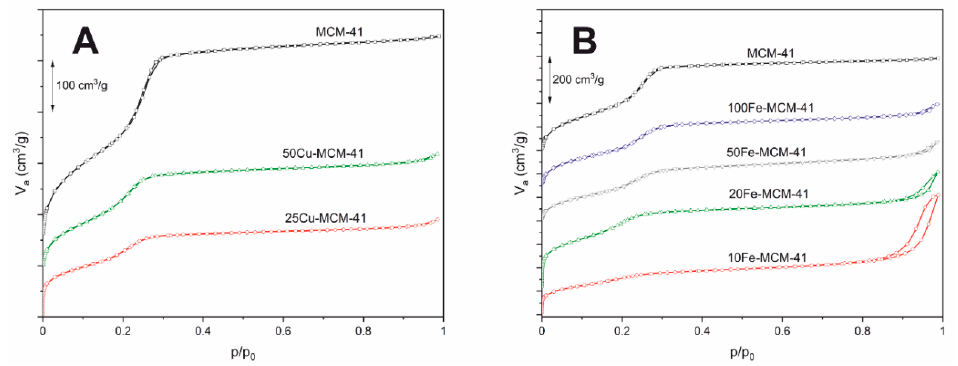
Figure 2. N 2 adsorption-desorption isotherms of the spherical MCM-41 samples containing Cu ( A ) and Fe ( B ).